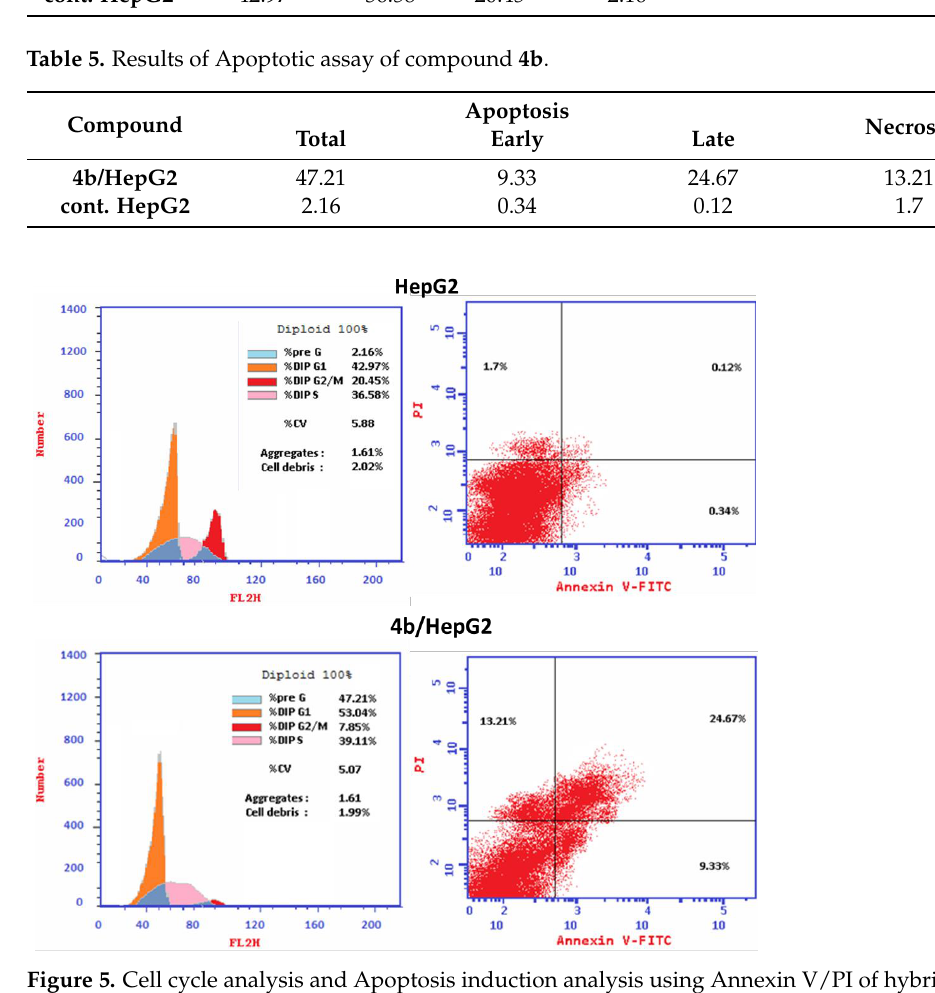
Table 3. Caspase-3, Caspase-8, Bax and Bcl-2 levels for hybrid 4b and staurosporine on HepG2 cancer cell line.